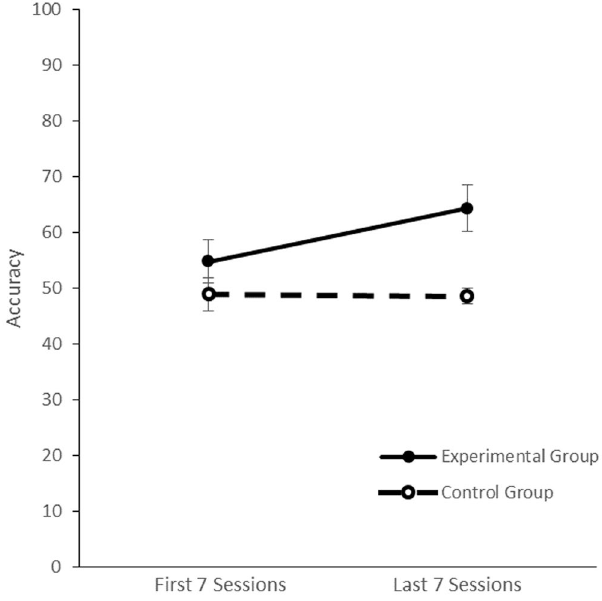
Figure 1. Training data for experimental (n = 6) and control (n = 5) group: % accuracy of responses to the odour stimuli in the first seven vs. last seven sessions.